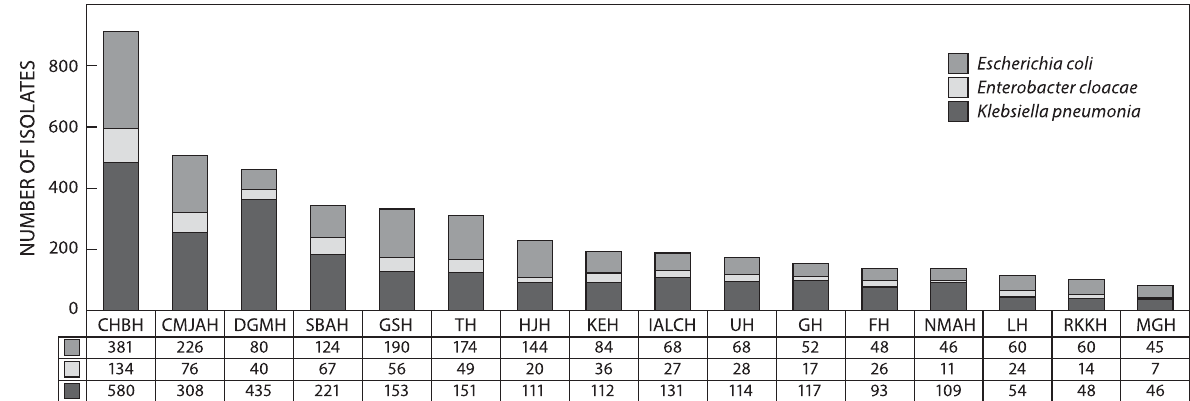
Figure 1: Number of Enterobacteriaceae: Klebsiella pneumoniae ( n = 2 783), Escherichia coli ( n = 1 850) and Enterobacter cloacae ( n = 632) reported from 16 sentinel hospitals across South Africa, January 1, 2016 to December 31, 2016. Abbreviations: Chris Hani Baragwanath Hospital (CHBH), Charlotte Maxeke Johannesburg Academic Hospital (CMJAH), Dr George Mukhari Hospital (DGMH), Steve Biko Academic Hospital (SBAH), Groote Schuur Hospital (GSH), Tygerberg Hospital (TH), Helen Joseph Hospital (HJH), King Edward VIII Hospital (KEH), Inkosi Albert Luthuli Central Hospital (IALCH), Universitas Hospital (UH), Grey ’ s Hospital (GH), Frere Hospital (FH), Nelson Mandela Academic Hospital/Mthatha Tertiary (NMAH), Livingstone Hospital (LH), RK Khan Hospital (RKKH) and Mahatma Gandhi Hospital (MGH), number of isolates ( n